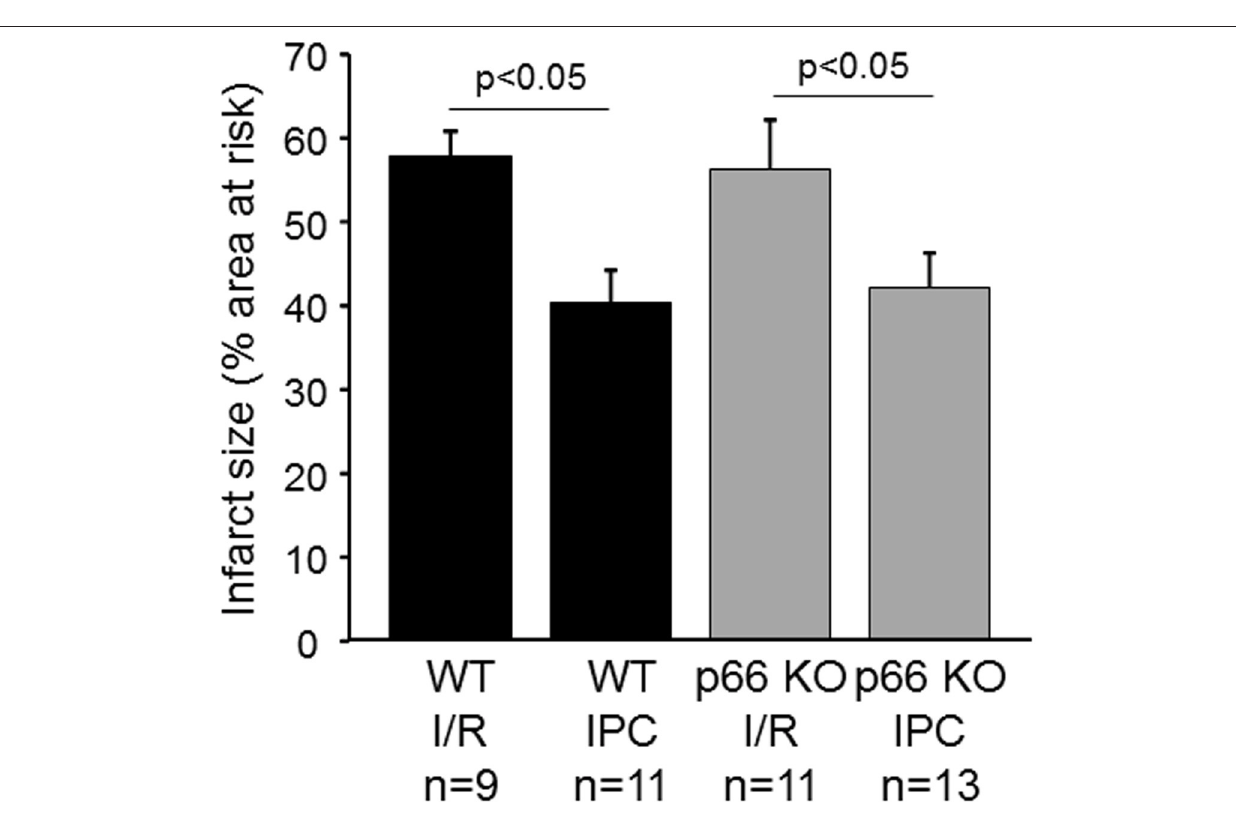
in mitochondria isolated from p66shc-deficient mice ROS formation was not different in SSM and IFM after IR indicating that p66shc contributes sufficient amounts to the ROS formation induced by myocardial